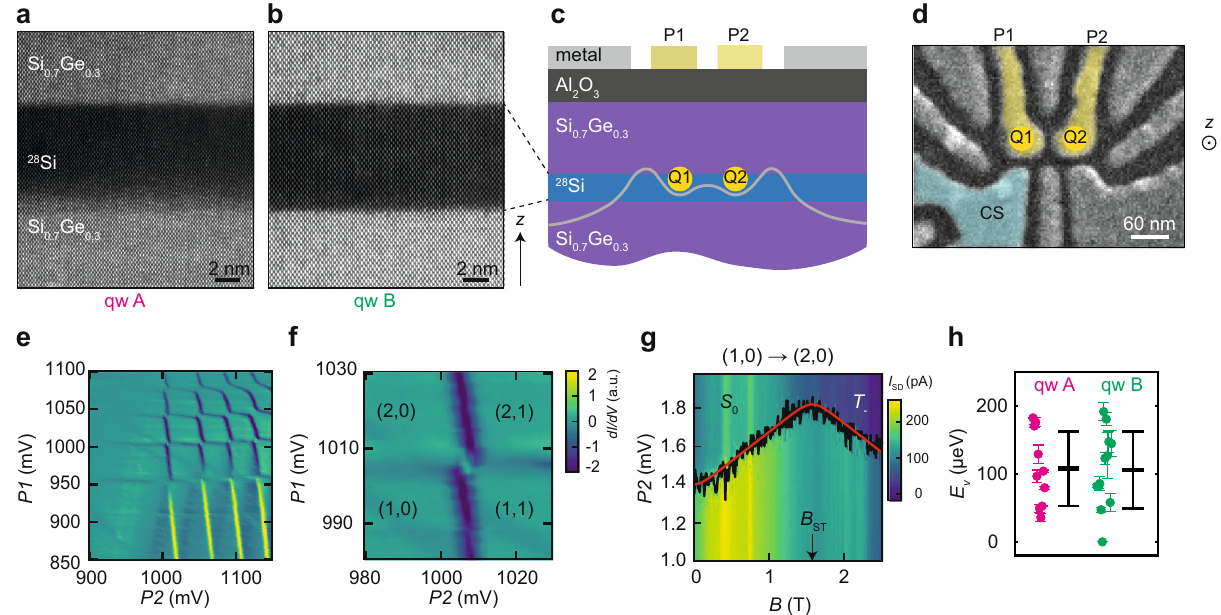
Fig. 1 | Material stack, devices, and valley splitting measurements. a , b High- angleannulardark fi eldscanningtransmissionelectronmicroscopy(HAADF-STEM) of 28 Si/SiGe quantum wells A and B, respectively. c , d Schematic cross-section of a heterostructurewith gate layout and false-coloured scanning electron microscope image of a double quantum dot, respectively. Q1 and Q2 are the quantum dots de fi ned through con fi nement potentials (schematic, grey line) formed below plunger gates P1 and P2. CS is a nearby quantum dot used as a charge sensor. e TypicalstabilitydiagramofadoublequantumdotformedbyplungergatesP1and P2 and measured by a nearby charge sensor (CS in d ). f Close-up of the stability diagram in the few-electron regime. g Typical magnetospectroscopy of the (1,0) → (2,0) transition, used to measure singlet-triplet splittings. An offset of 1082 mVissubtractedforclarityfromthegatevoltageappliedtoP2.Blacklinesshowthe